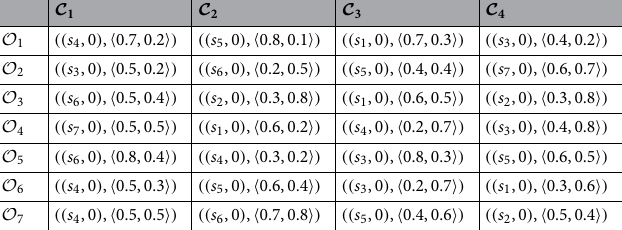
Table 1. q-ROPFL data provided by D 1 .